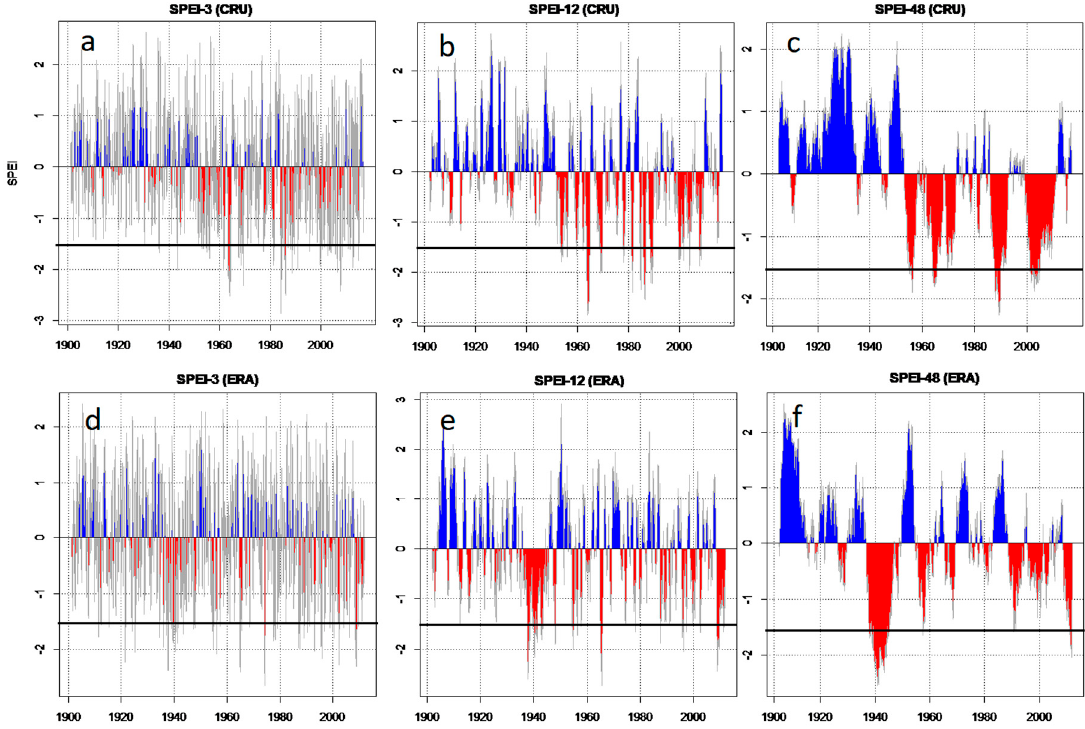
Figure 8. As in Figure 5, but for the CWSP region. Table 3. Spearman correlation coefficients between variables obtained from CRU/ERA20C and from conventional weather stations in CWSP and ESP, for the period 1986–2010. Mean Temperature